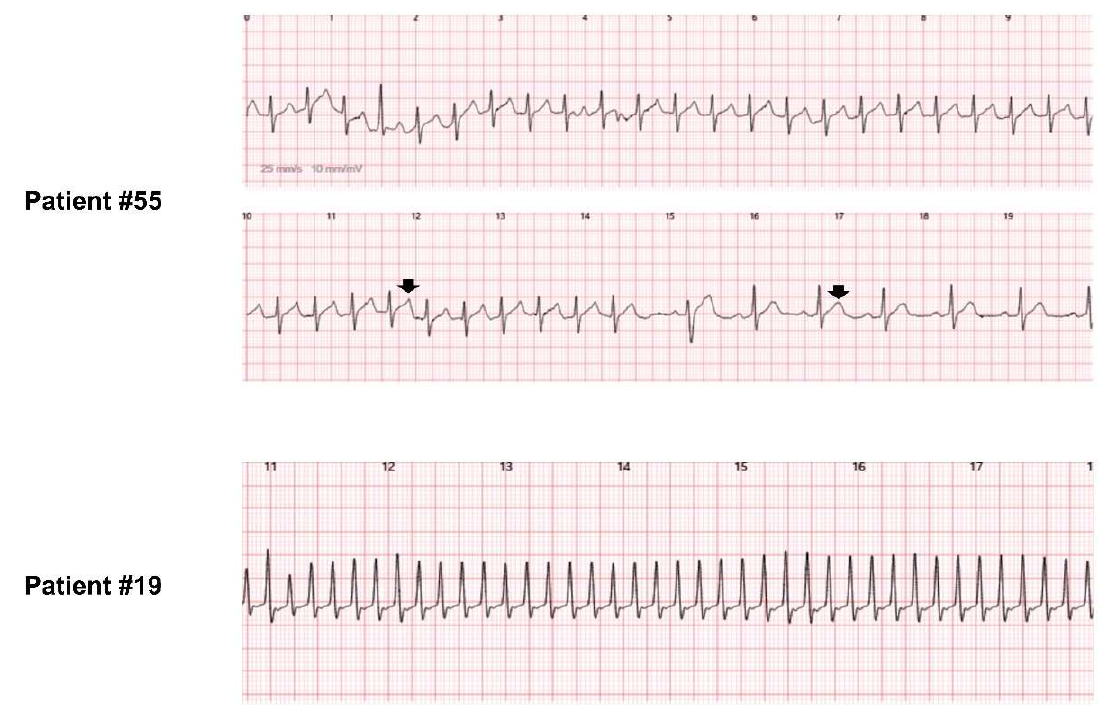
Figure 4. Paroxysmal supraventricular tachycardia and atrial tachycardia detected by the w-ECG. Patient #55 was diagnosed with paroxysmal supraventricular tachycardia using the w-ECG, and electrophysiology study revealed atrioventricular nodal reentrant tachycardia, fast–slow type. Dif- ferent T-wave morphology during tachycardia and sinus rhythm (black arrows) is compatible with atrioventricular nodal reentrant tachycardia, fast–slow type. Sudden termination of tachycardia was clearly recorded, and the mode of termination was A-no-V, suggestive of paroxysmal supraventricular tachycardia. This image suggests that the w-ECG can detect subtle differences in T-wave morphology. Patient #19, with a prior history of radiofrequency catheter ablation for atrial fibrillation, was diag- nosed with narrow QRS complex tachycardia using the w-ECG. Electrophysiology demonstrated that the tachycardia was atypical atrial flutter, and it was successfully ablated. w-ECG: watch-type ECG device.